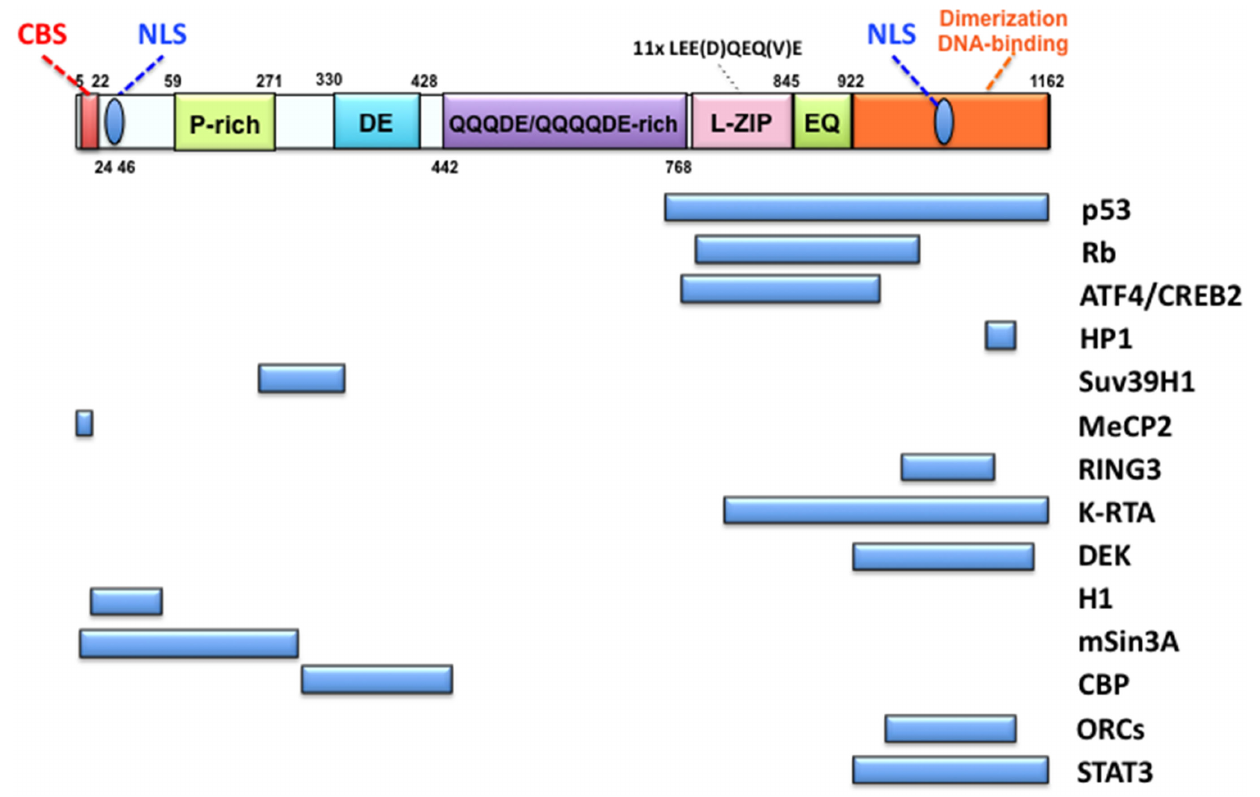
FIGURE 2 | Organization of LANA and its interacting proteins. The top Figure shows the organization of the LANA protein. LANA has two nuclear localization signals (NLS): one at the N-terminal region and the other at the C-terminal region.The former is a primary NLS and the latter is cryptic. A chromosome binding site (CBS) was reported to be present at the N-terminal end as a histone H1 binding region.The mid-part of LANA consists of a very peculiar amino acid composition called a proline-rich region (P-rich), an